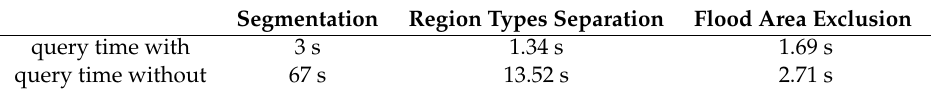
Table 3. The average of the query response time with and without the criteria mentioned in the query. Each average time value has been calculated over running 50 different